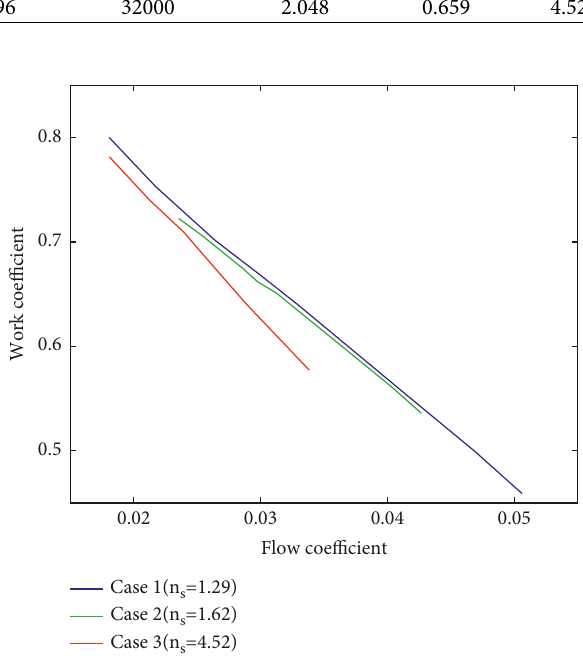
Figure 22: Work coefficient of test